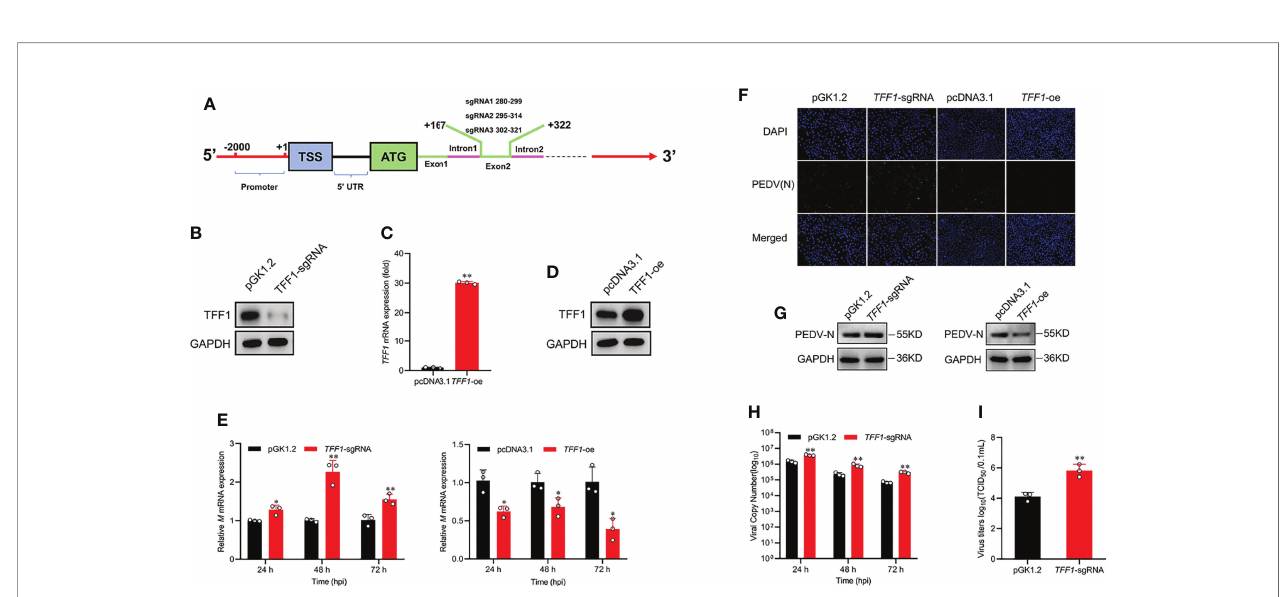
FIGURE 2 | TFF1 inhibits PEDV replication. (A) The location of the three sgRNAs (sgRNA1, sgRNA2, sgRNA3) used for TFF1 knockout. (B) Western blot was performed to detect the knockdown ef fi ciency of TFF1 -sgRNA mixture pool cells compared with the pGK1.2 vector in IPEC-J2 cell lines. (C, D) Protein and mRNA levels of TFF1 were determined in IPEC-J2 transfected with TFF1 -oe. (E) mRNA levels of M gene in IPEC-J2 transfected with TFF1 -sgRNA and/or TFF1 - oe after PEDV infection at MOI of 0.1 for 24, 48, and 72 hours. (F, G) The indirect immuno fl uorescence assay and western blotting were performed to detect PEDV (N) in PEDV-infected cells. TFF1 -sgRNA and TFF1 -oe cells were infected with PEDV at MOI of 0.1, respectively. (H) The PEDV genome copy number was measured by RT-qPCR. (I) Cell culture supernatants were collected at 24, 48, and 72 hours PEDV post infection and titrated for TCID50. Data are presented as mean values ± SD, using two tailed Student ’ s t-test . * p < 0.05, ** p < 0.01. Each treatment has triplicate biological replicates at